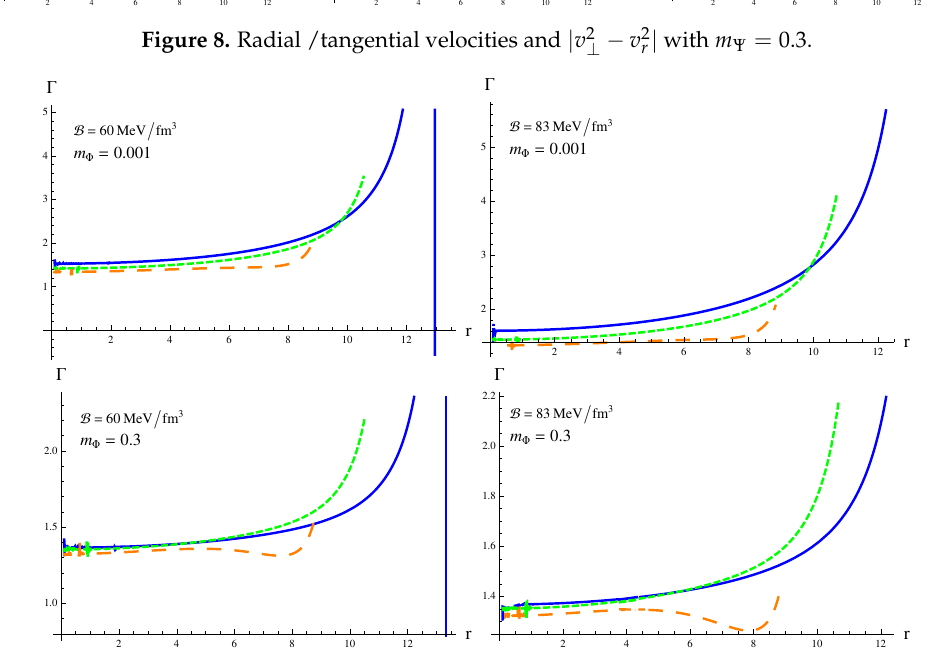
Figure 8. Radial /tangential velocities and | v 2 ⊥ − v 2 r | with m Ψ = 0.3.